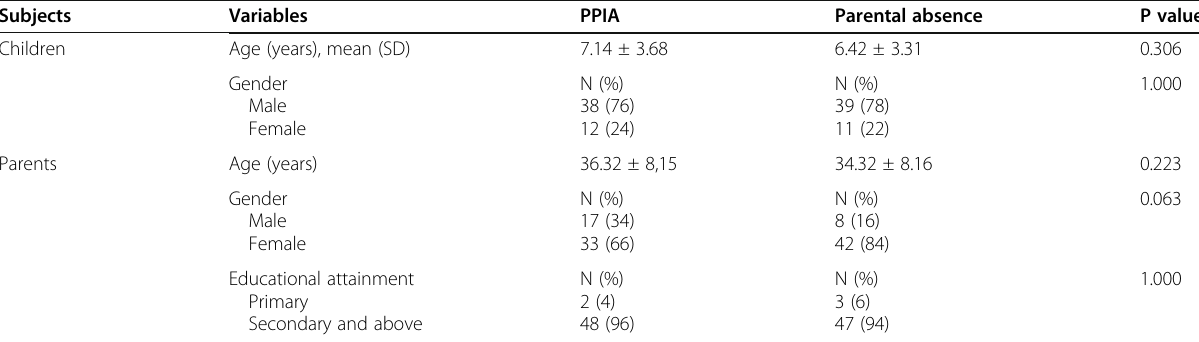
Table 1 Demographic characteristics of patients and parents Subjects